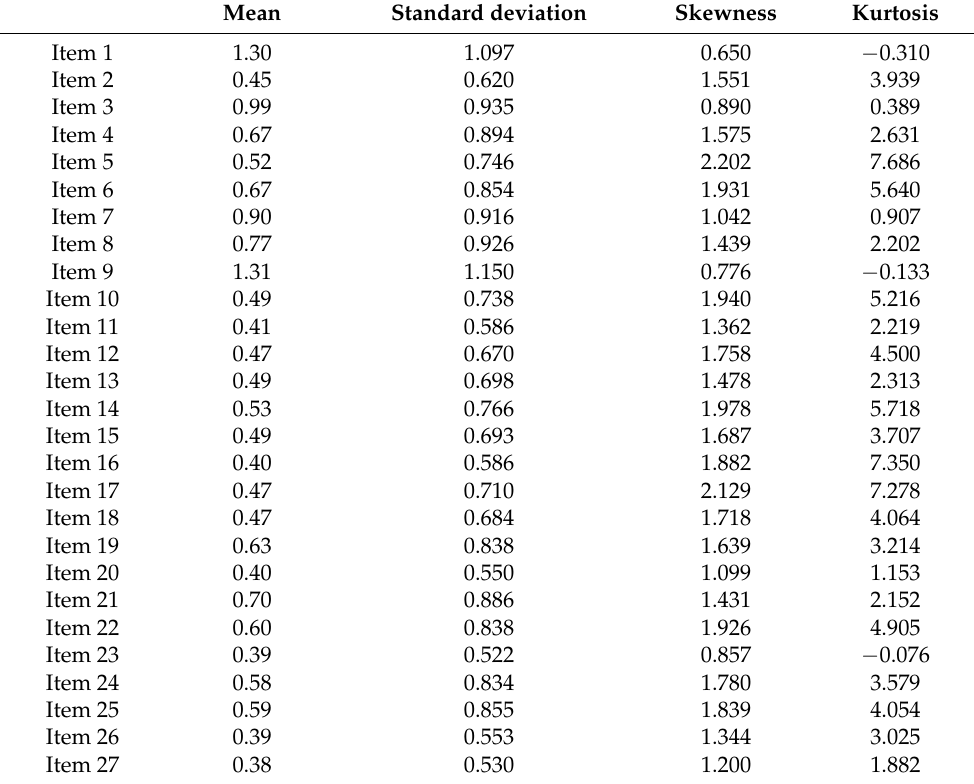
Table 2. Mean, standard deviation, skewness, and kurtosis of the RTSHIA items.